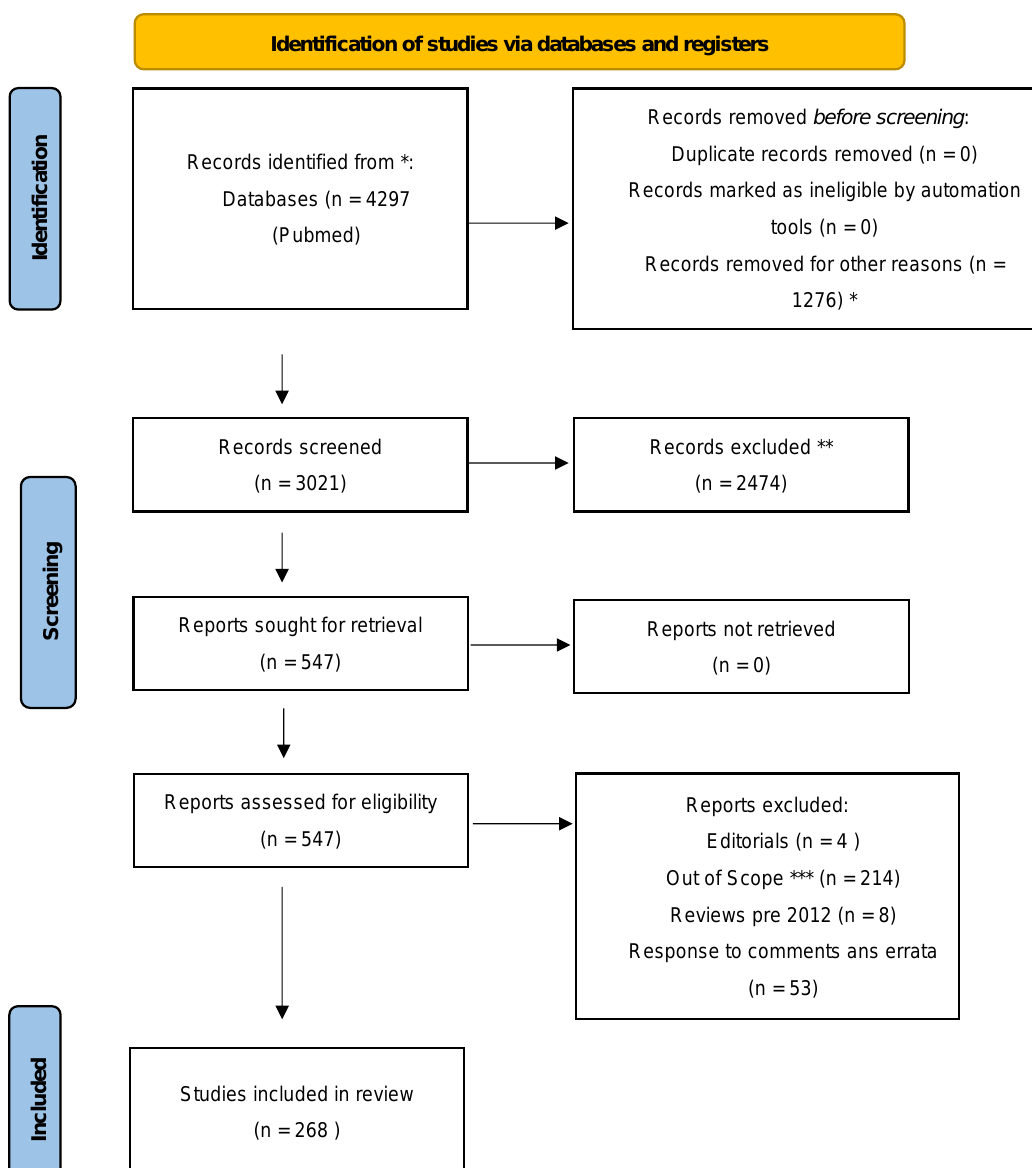
Figure 1. Flow Chart depicting a summary of Cornea Transplant. * 1276 records were excluded for being out of range chronologically; ** Records that did not contain the word transplant in their title were removed; *** Records were based on limbal and other body parts